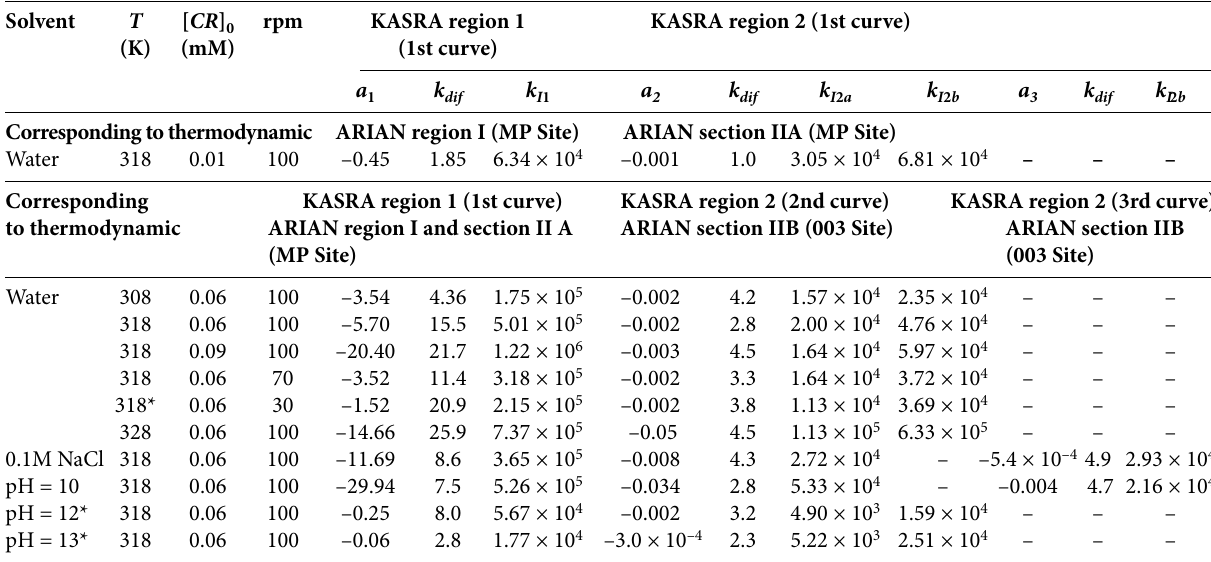
Table 5 . Adsorption acceleration values, intraparticle diffusion constants and ISO rate constants for kinetics of CR adsorption on Mg-Al-LDH na- nocompound at different temperatures and in various shaking rates and initial CR concentrations. Solvent T